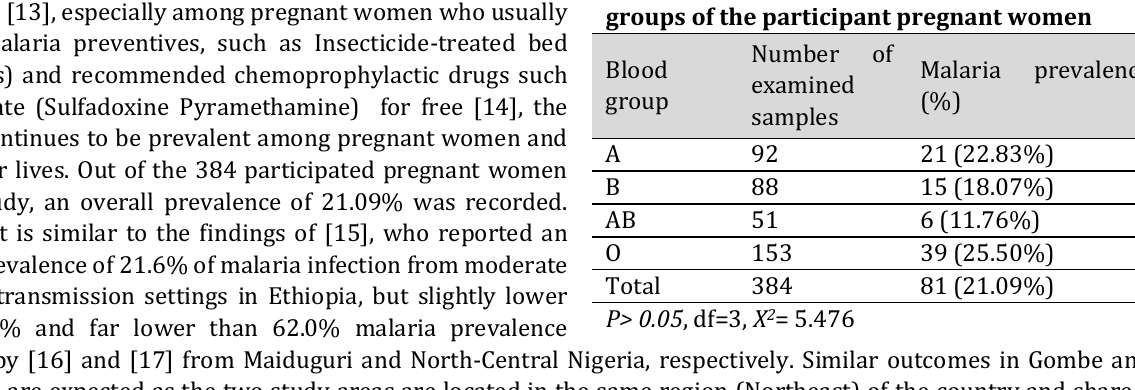
Table 2. Malaria prevalence in relation to blood